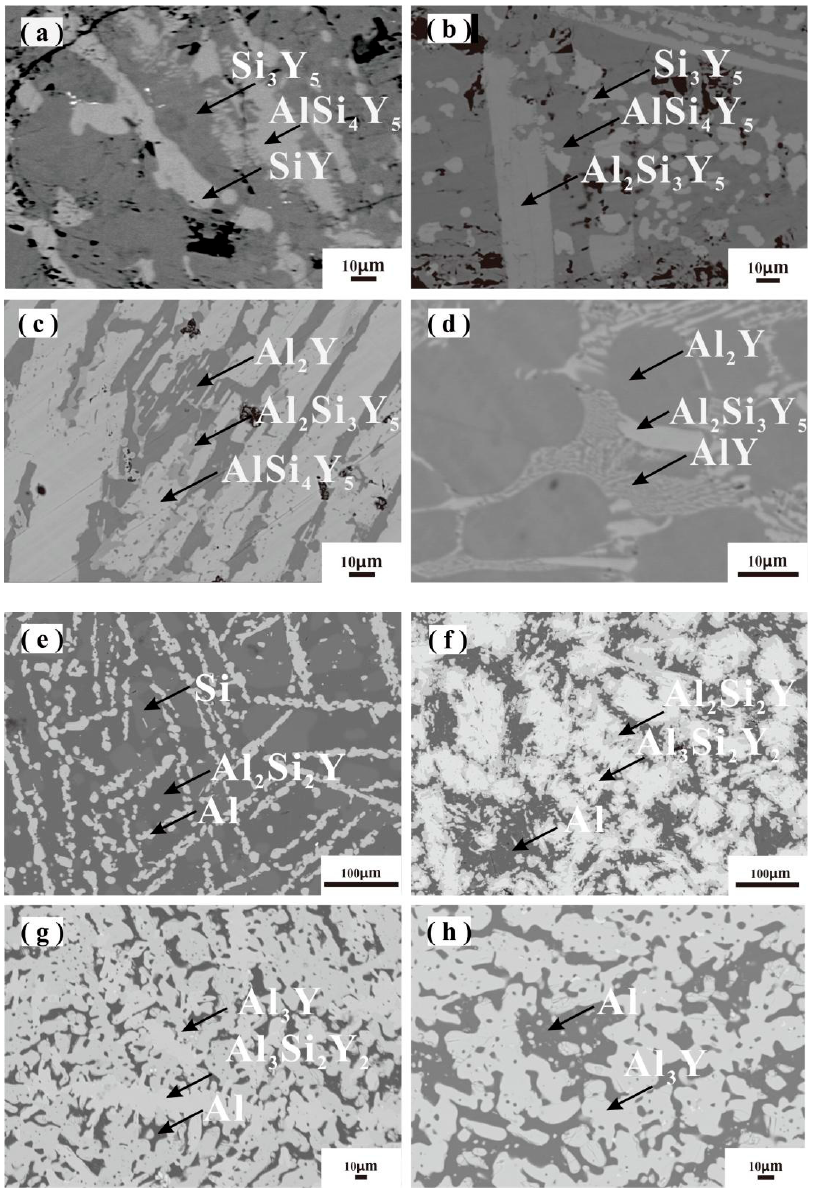
Figure 3. The BSE images of No. 55, No. 56, No. 72, No. 43, No. 32, No. 36, No. 26 and No. 15 alloy samples: ( a ) No. 55. Al 5.2 Si 42 Y 52.8 ; ( b ) No. 56. Al 10.6 Si 36.2 Y 53.2 ; ( c ) No. 72. Al 23.3 Si 30.5 Y 46.2 ; ( d ) No. 43. Al 60 Si 4 Y 36 ; ( e ) No. 32. Al 60 Si 36 Y 4 ; ( f ) No. 36. Al 60 Si 23 Y 17 ; ( g ) No. 26. Al 70 Si 10 Y 20 ; ( h ) No. 15. Al 80 Si 2.5 Y 17.5 .